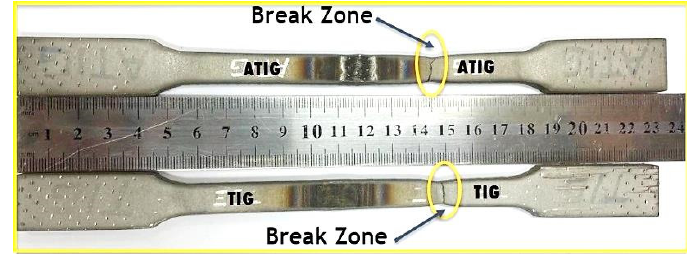
Figure 7. Failure zone in tensile test for ATIG and TIG welds.